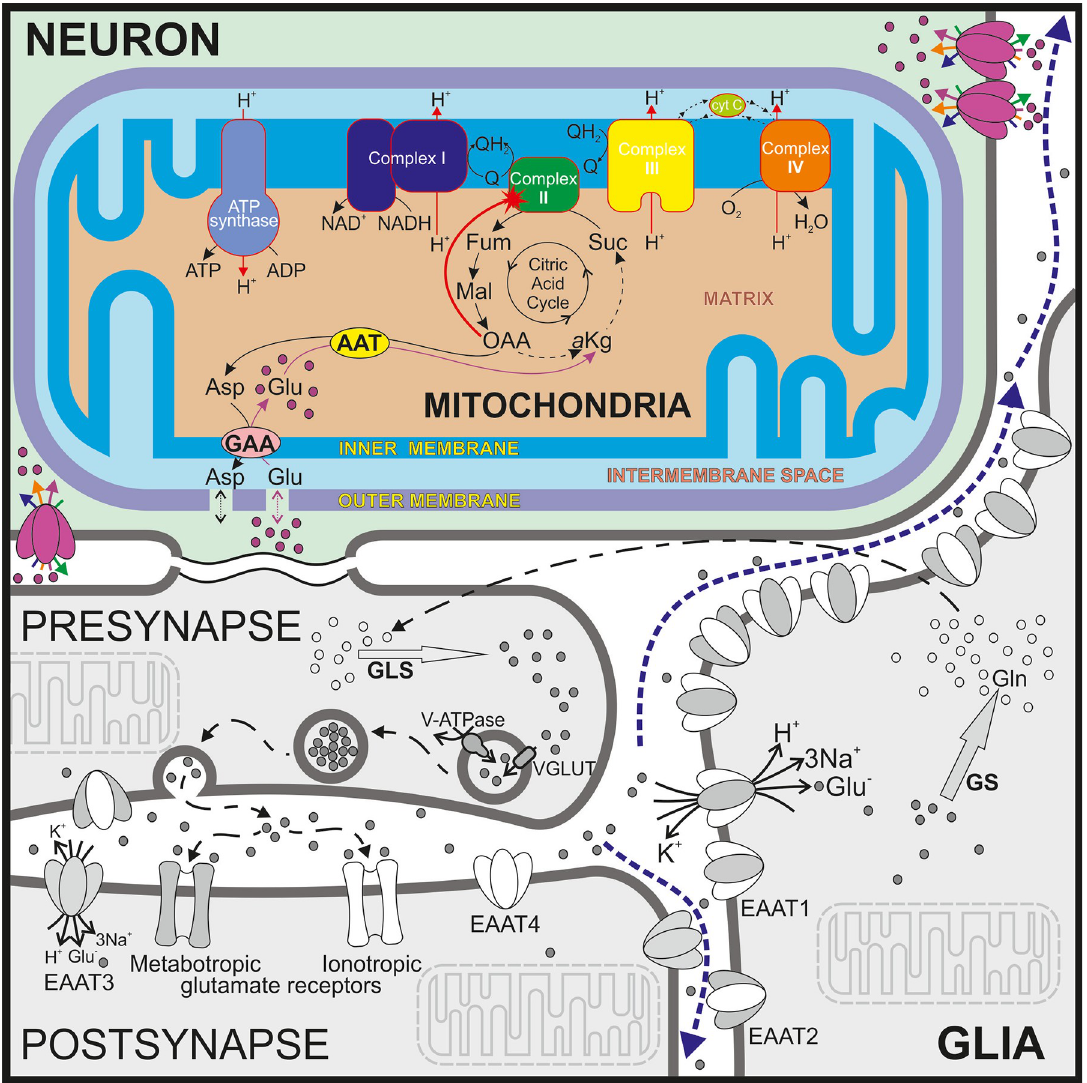
Fig 1. Extended scheme of glutamate involvement in complex II regulation. While a whole system of principal glutamate reactions is shown, the subject of the model is painted in color. It illustrates the implementation in the model mechanism of complex II activation by glutamate. The processes not included directly in the model are shown in grey. The most common glutamate-involved processes are separated in the different cells. Several types of transporters of the EAAT family are indicated in appropriate membranes. The metabolic reactions of GLS, GS, GDH, and AAT are shown in local areas of a neuron (presynapse and postsynapse) and glia. Dashed blue arrows indicate spillover of glutamate. According to the specificity of glutamate transporter localization [3, 21, 23], EAAT3 is considered as the carrier used in the model. The reactions in a neuroplasm (for example glycolysis, NADH metabolism, etc) are omitted for the clearaty of presentation.